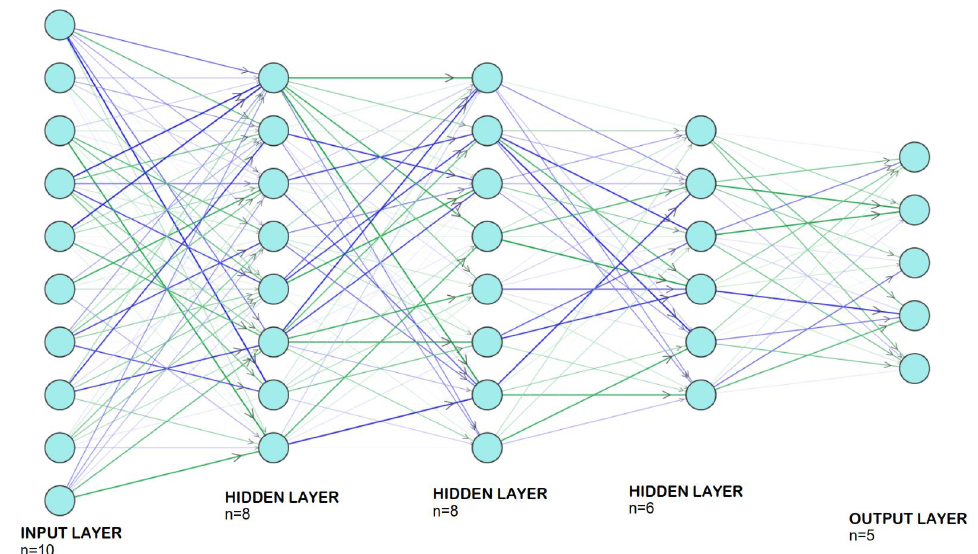
Figure 1. Deep neural network general topology